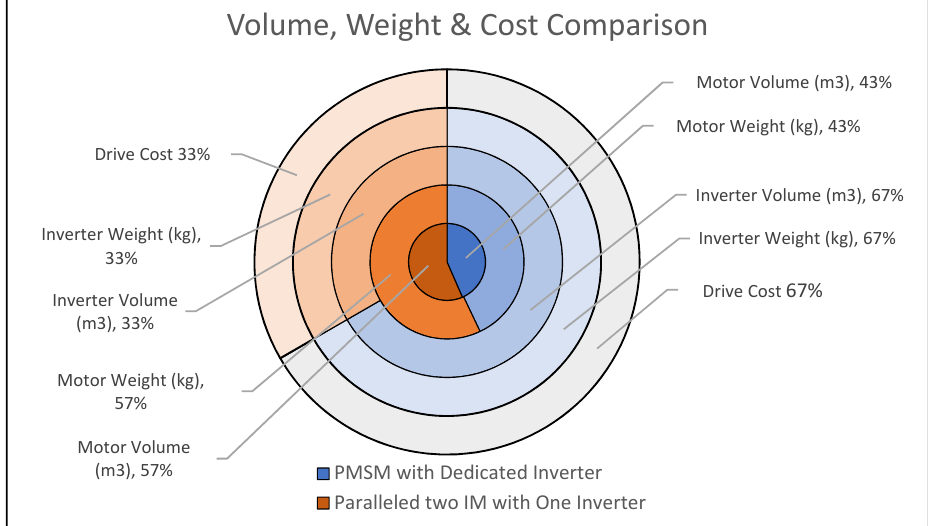
Figure 8. Volume and weight comparison charts for two configurations.